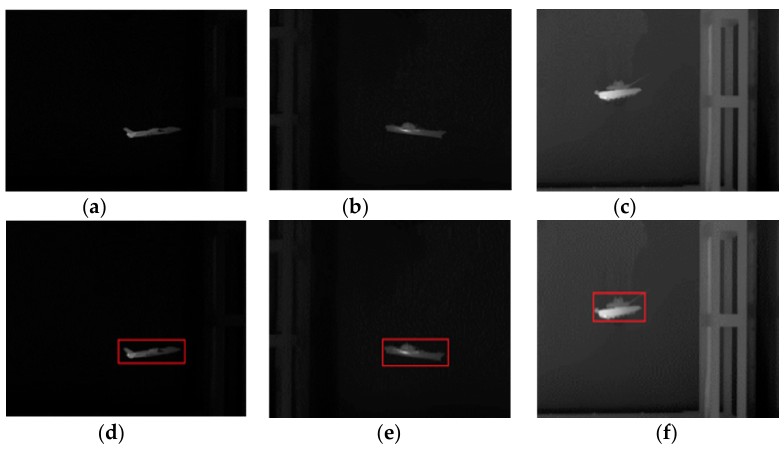
Figure 8. Original images and initial contours used in the experiment. ( a ) “plane”; ( b ) “ship”; ( c ) “tank”; ( d ) Initial contour of “plane” (size: 165 × 75); ( e ) Initial contour of “ship” (size: 158 × 86); ( f ) Initial contour of “tank” (size: 123 × 98).